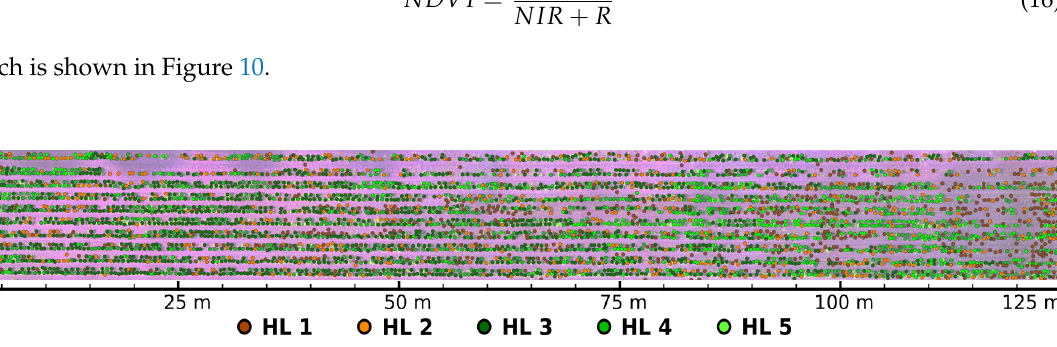
Figure 9. Automated seeding point detection and classification on the study area.